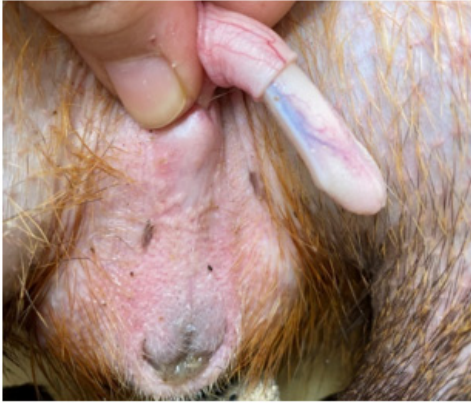
Figure 1. Penis showing lateral cartilage.